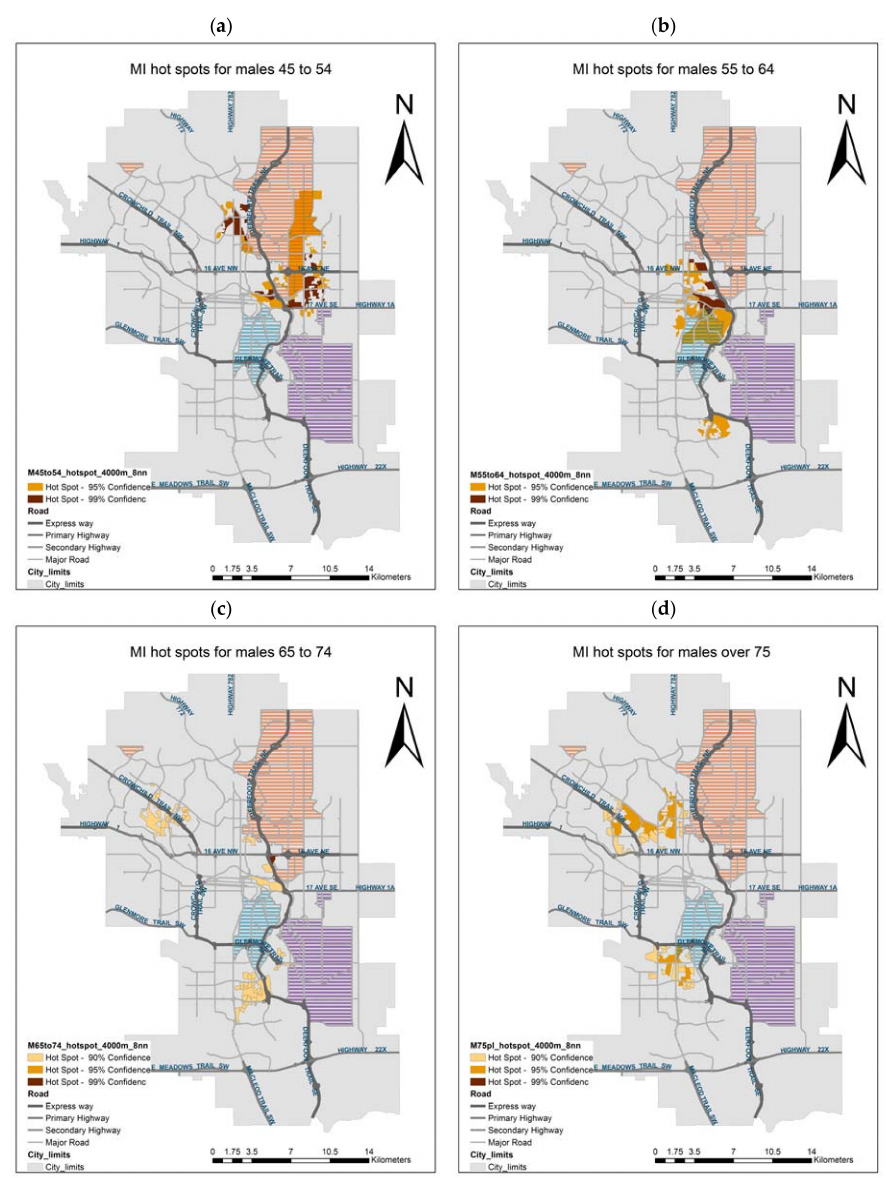
Figure 8. MI hot spots of males ( a ) 45 to 54, ( b ) 55 to 64, ( c ) 65 to 74, and ( d ) over